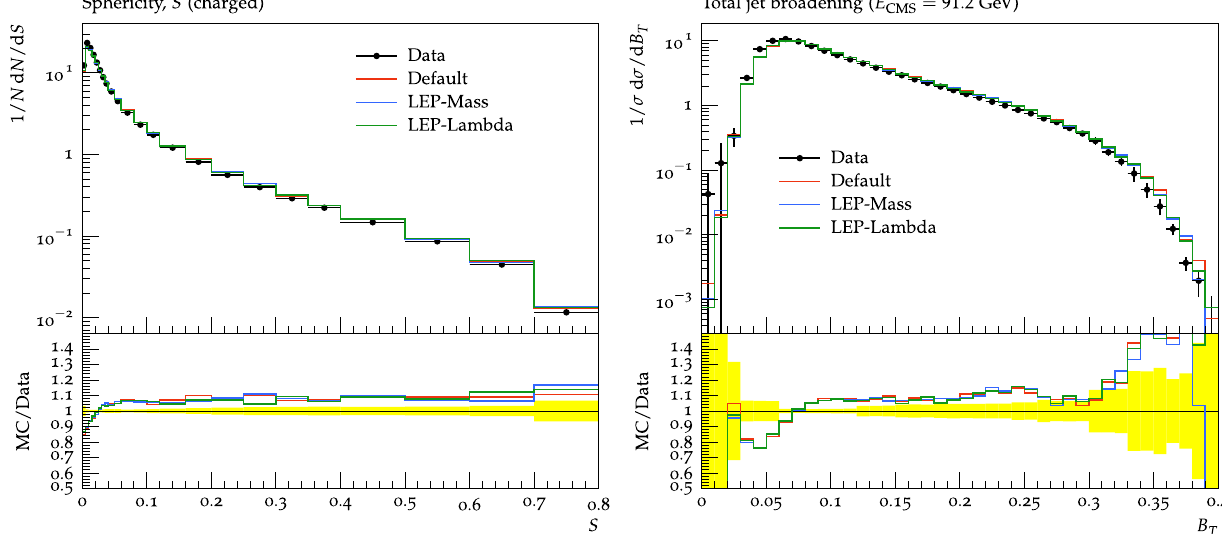
Fig. 12 Event-shapeobservablesfromALEPH[20,21],comparingtheresultsofdefaultHerwigtoournewLEPtunednon-perturbativestrangeness production scaling, for both mass and λ measures. The new scaling does not impact on event-shape